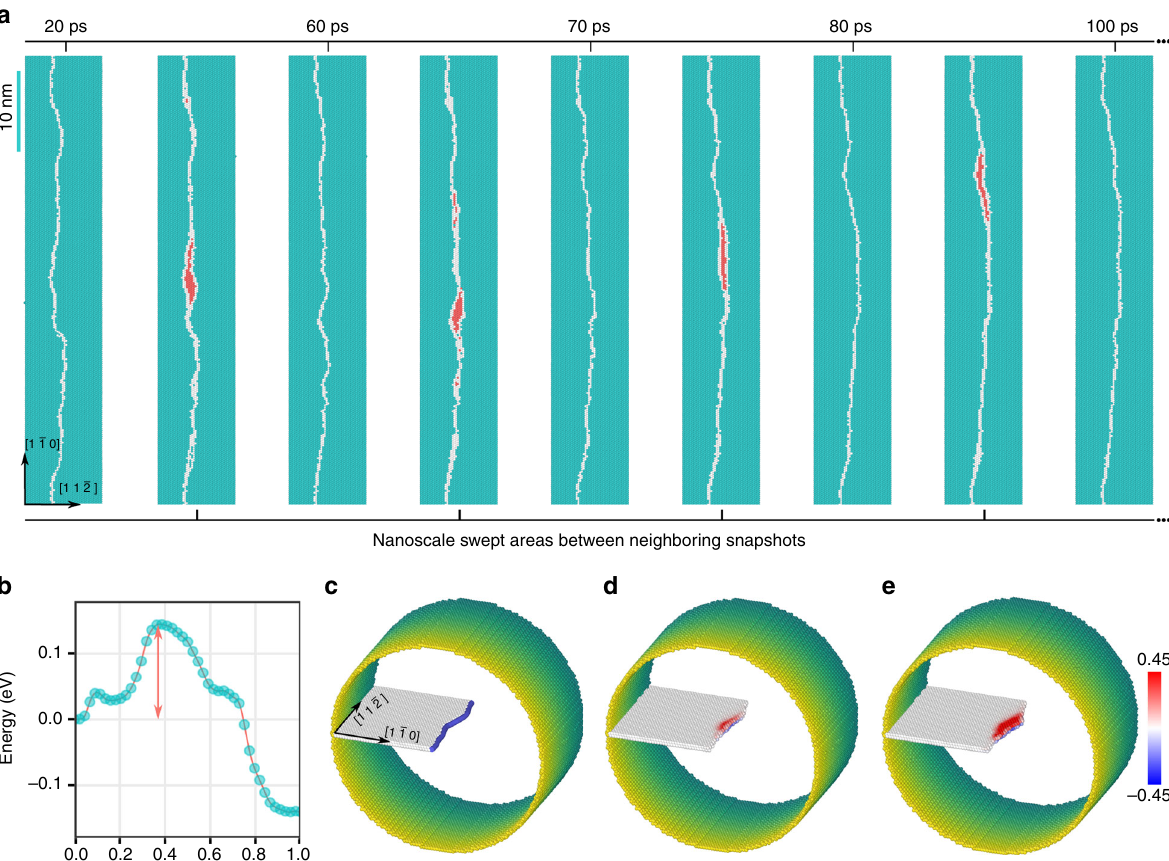
by either simultaneously propagating a long dislocation line (see Supplementary Fig. 13 for an example of Cu), or bow out in between unshearable obstacles that are spaced quite some dis- tance (at least many nanometers) apart.